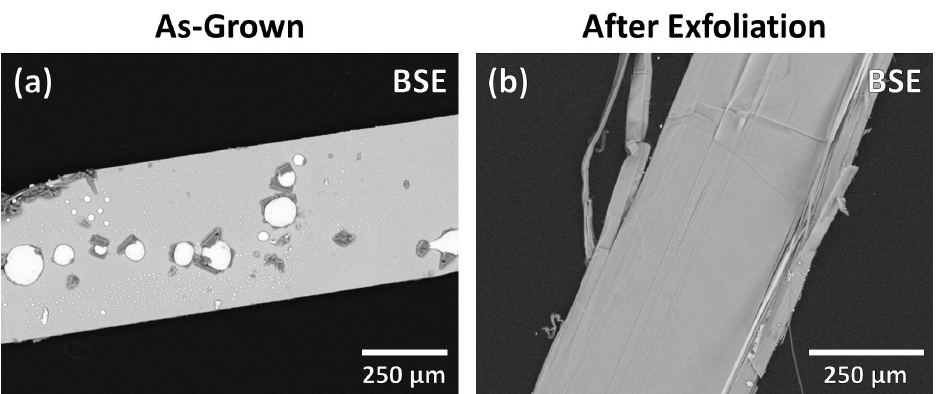
Figure 3. SEM image with chemical contrast (BSE detector) of ( a ) an as-grown crystal of AgCrP 2 S 6 with superficial impurities and ( b ) a piece of the same crystal after exfoliation with a clean surface.